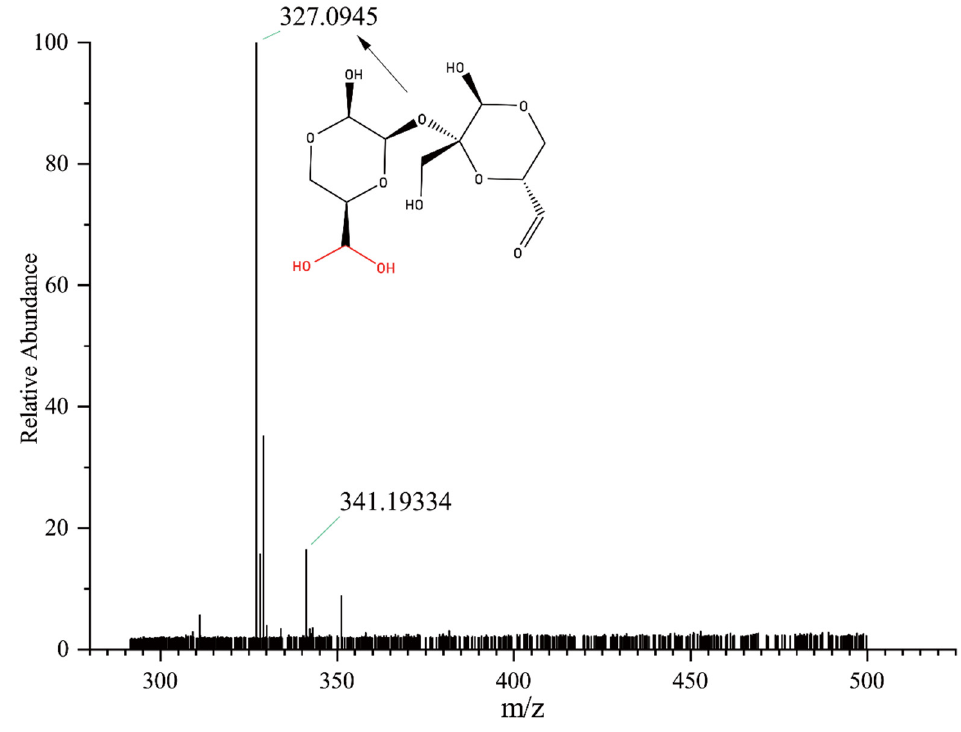
Figure 5. High-resolution mass spectrometry of OS(B).